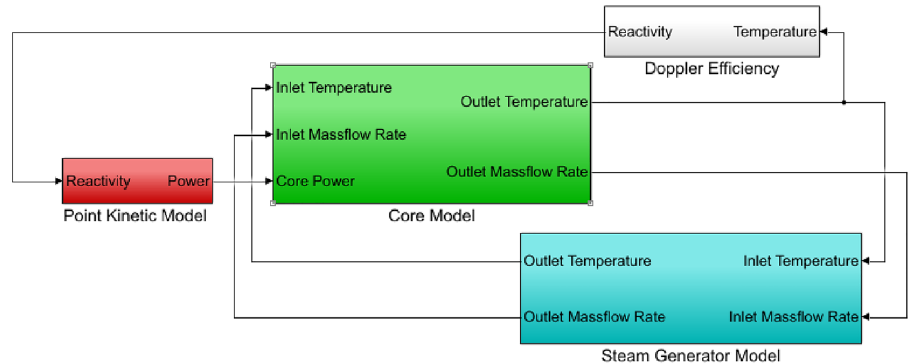
Figure 3. Open-loop model of reactor neutron dynamics coupled with thermal hydraulics.